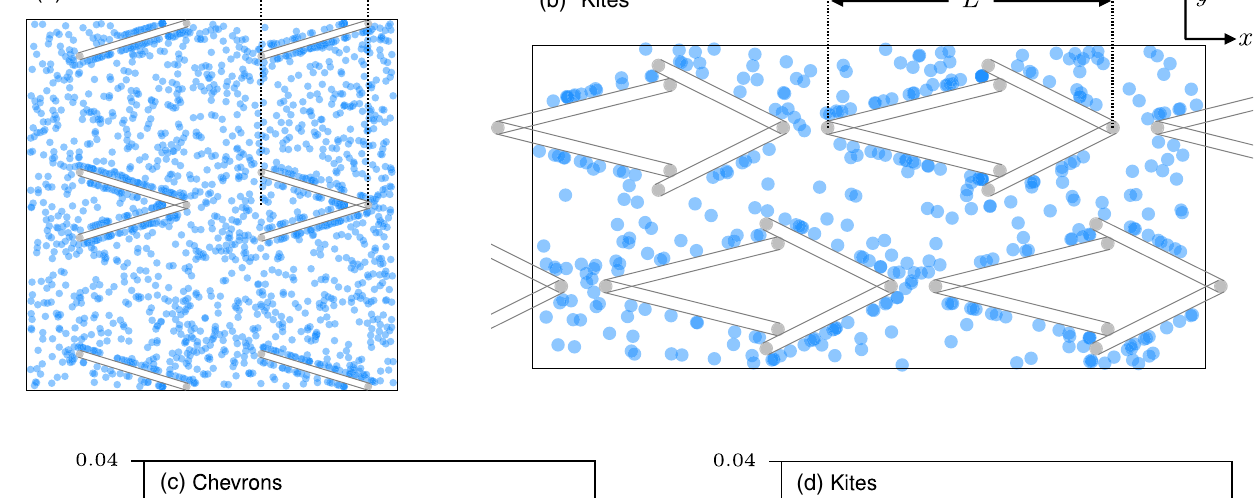
and the efficiency η are, respectively, shown for (c),(e) chevrons and (d),(f) ex f =D a r of the active ac 1 , μ 1 ¼ μ V 10 2 , and L L 52 × 52 (chevrons) and p ¼ a , 0 ¼ x × y ¼ ac ¼